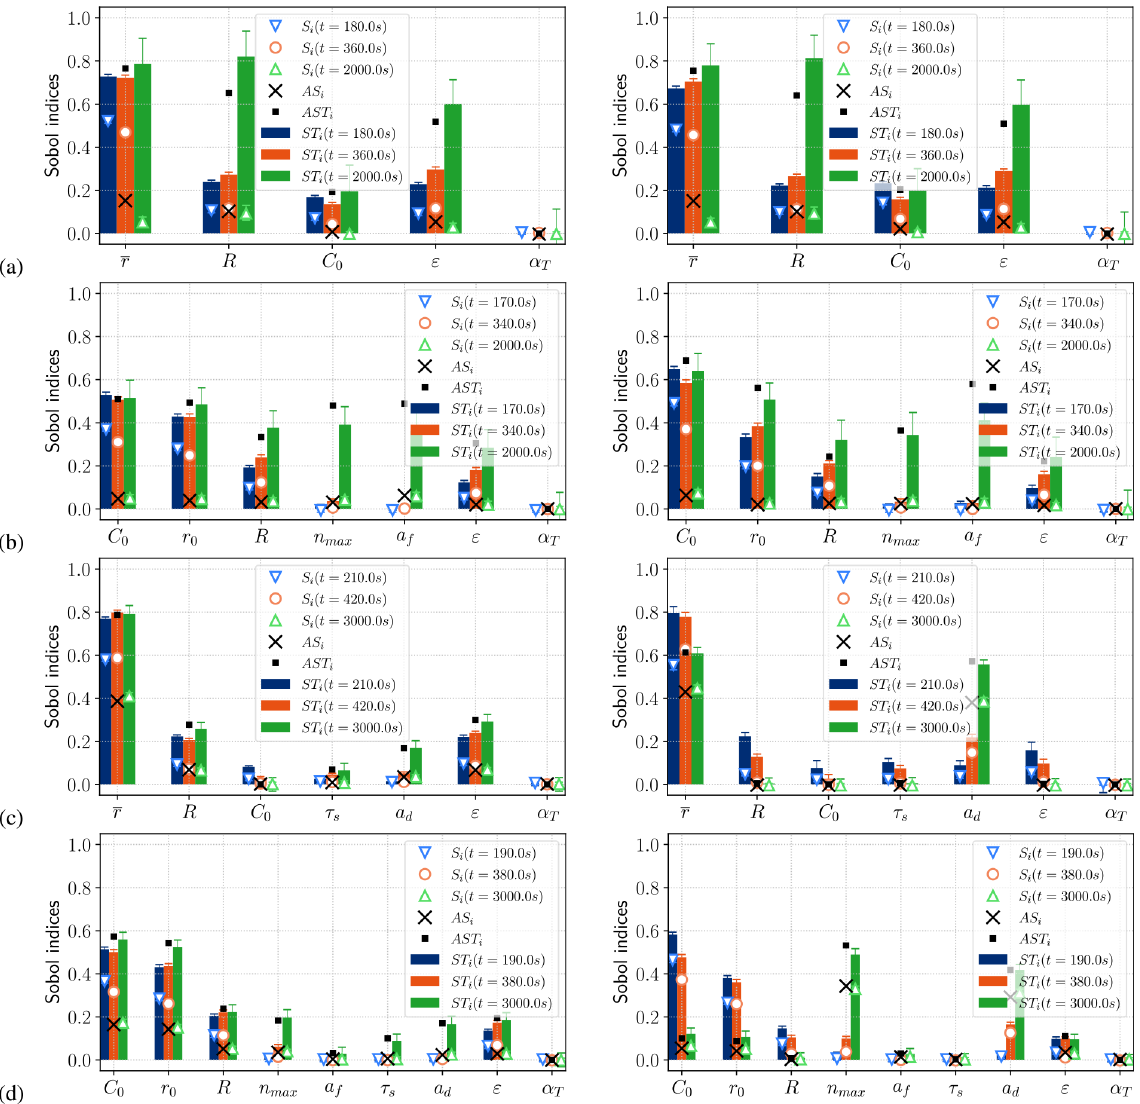
Figure D1. First-order and total-order Sobol indices at times t min , 2 t min and t f and aggregated Sobol indices for temperature (left panels) and frazil (right panels) for case 1 (a) , 2 (b) , 3 (c) and 4 (d) from top to bottom.